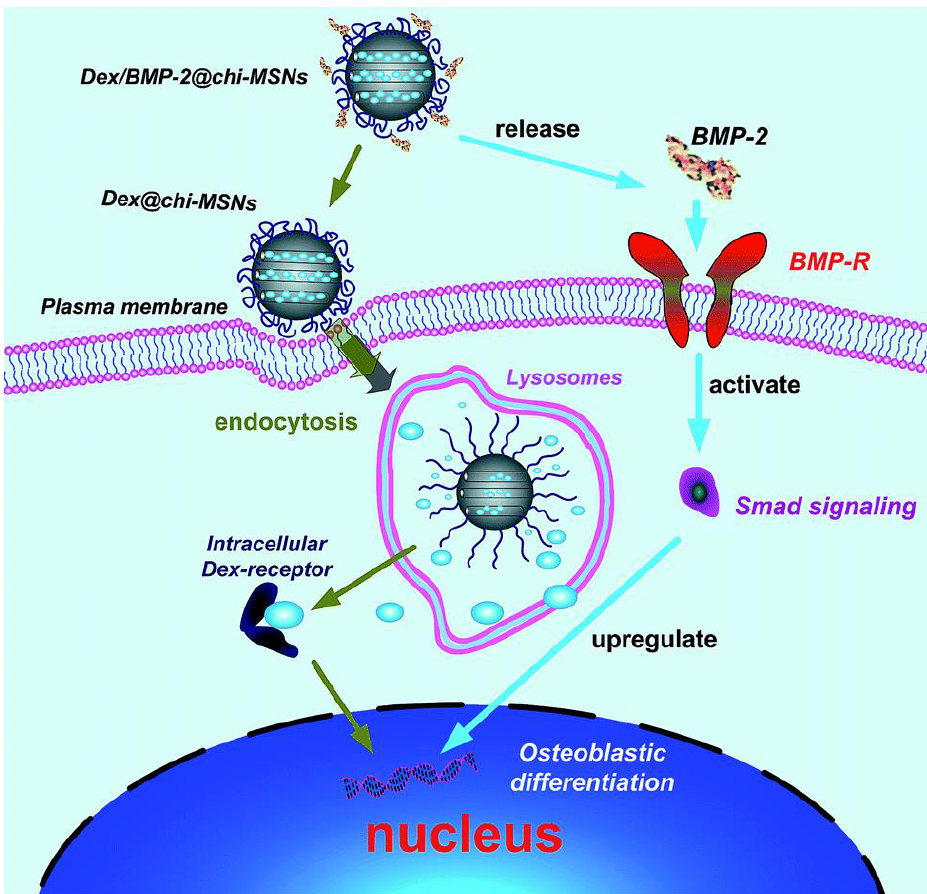
Figure 3. Schematic representation of the effect of chitosan-coated MSNs loaded with bone morphogenic protein-2 (BMP-2) and dexamethasone (Dex) in promoting osteoblasts differentiation. (Dex/BMP-2)@chi-MSNs are able to delivery BMP-2 extracellularly and Dex intracellularly, after the conformational change of chitosan coating triggered by lysosomal acidic pH. Reproduced with permission from ref. [142]. Copyright 2013, The Royal Society of Chemistry.